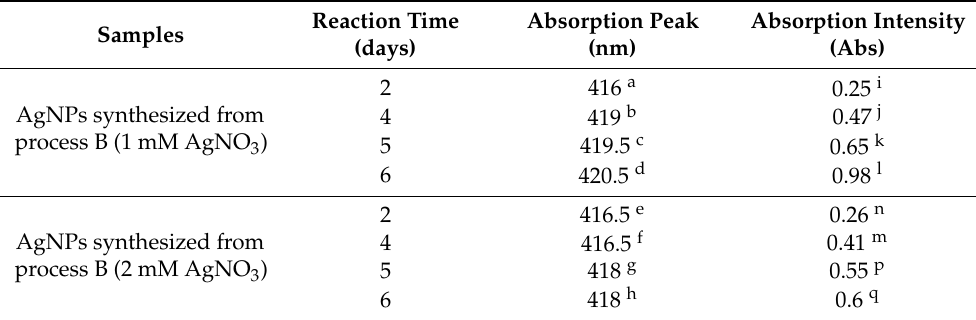
Table 1. The absorption peak positions and absorption intensity of AgNPs synthesized from process B.